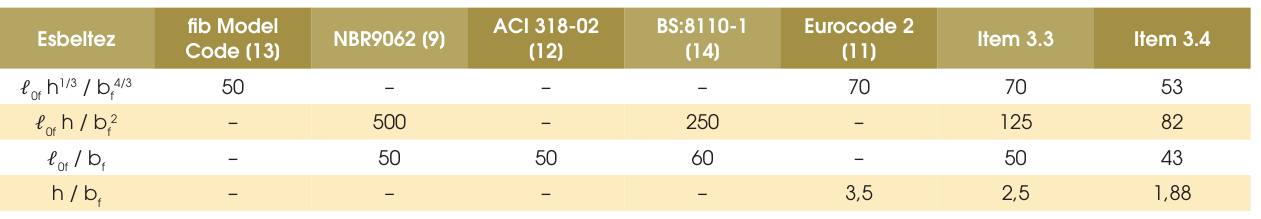
Table 9 – Comparison of slenderness limit results for I-section